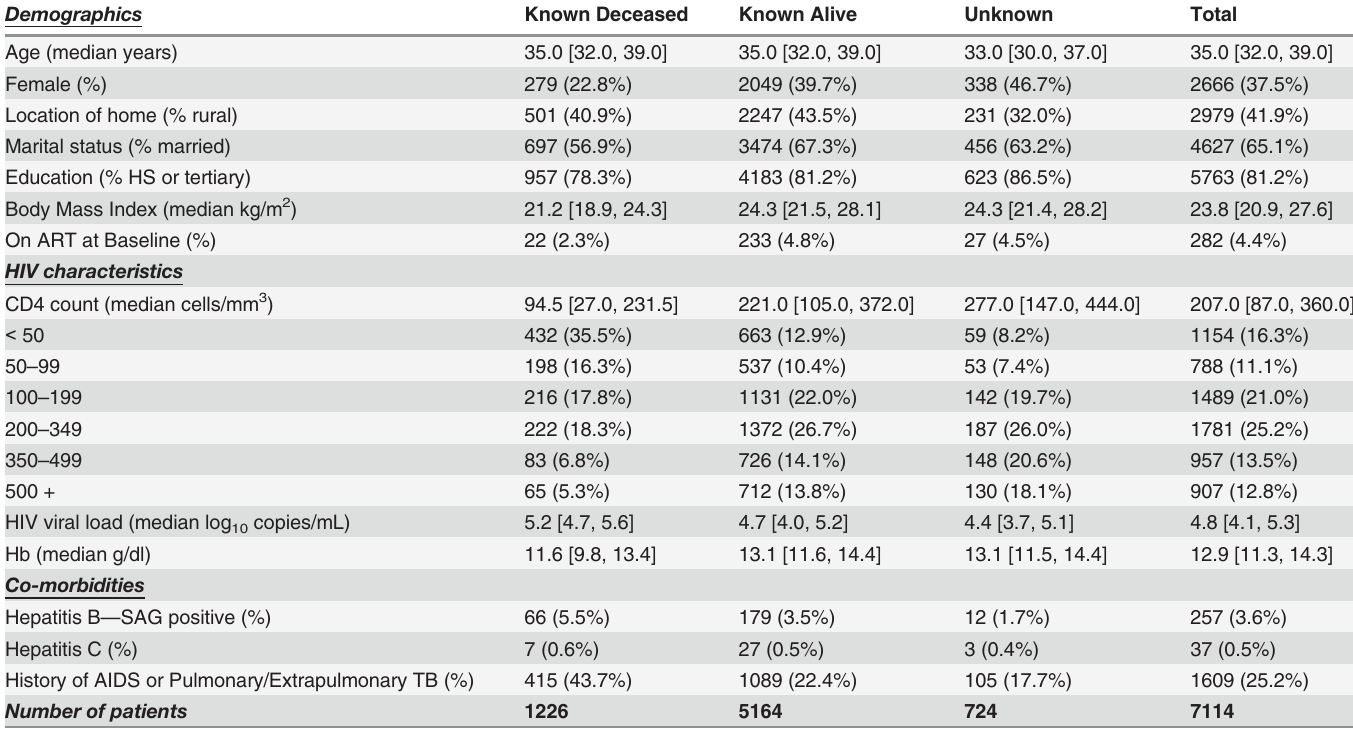
Table 1. Characteristics at Enrolment of Phidisa HIV Positive Participants by Mortality Status: Mortality